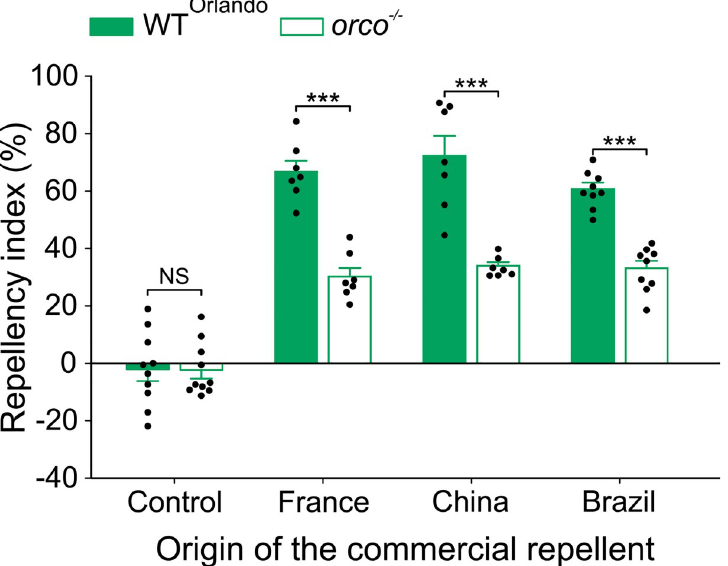
Fig 6. Repellency by commercial transfluthrin products consists of both Or-mediated and Or-independent repellency in Ae . aegypti . Dilutions were made in order to adjust the concentration of transfluthrin to 1 ppm, accordingly to the original concentration indicated in the product label. The Orlando and orco -/- mosquito lines were used. Student’s t -test, for control: t = 0.05, df = 18, P = 0.963, for France: t = 7.40, df = 12, P < 0.001, for Brazil: t = 8.31, df = 16, P < 0.001, Mann-Whitney Rank Sum test, for China: U = 0.0, P < 0.001, NS = not significant, ��� P < 0.001; n = 9 cages for Brazil in both lines, n = 10 cages for both controls, and n = 7 cages for the rest. The controls represent the baseline activity in response to the solvent. Data are presented as mean ± SEM. Each black circle over the bars represents individual replicate